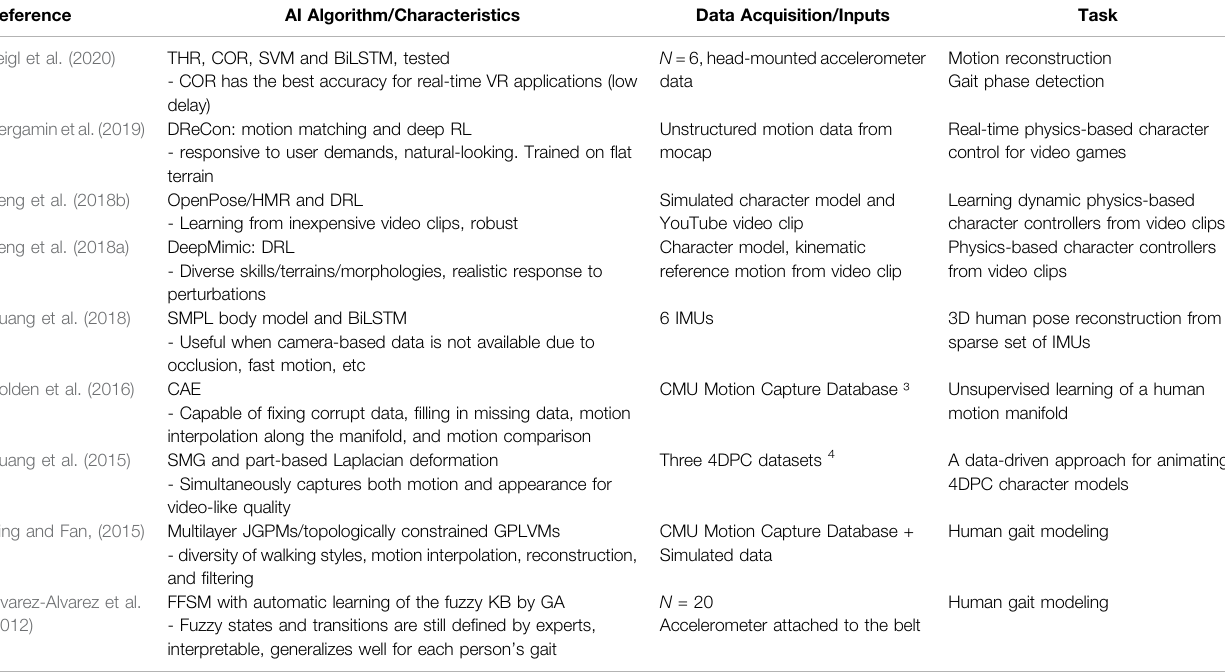
TABLE 14 | Animation and virtual